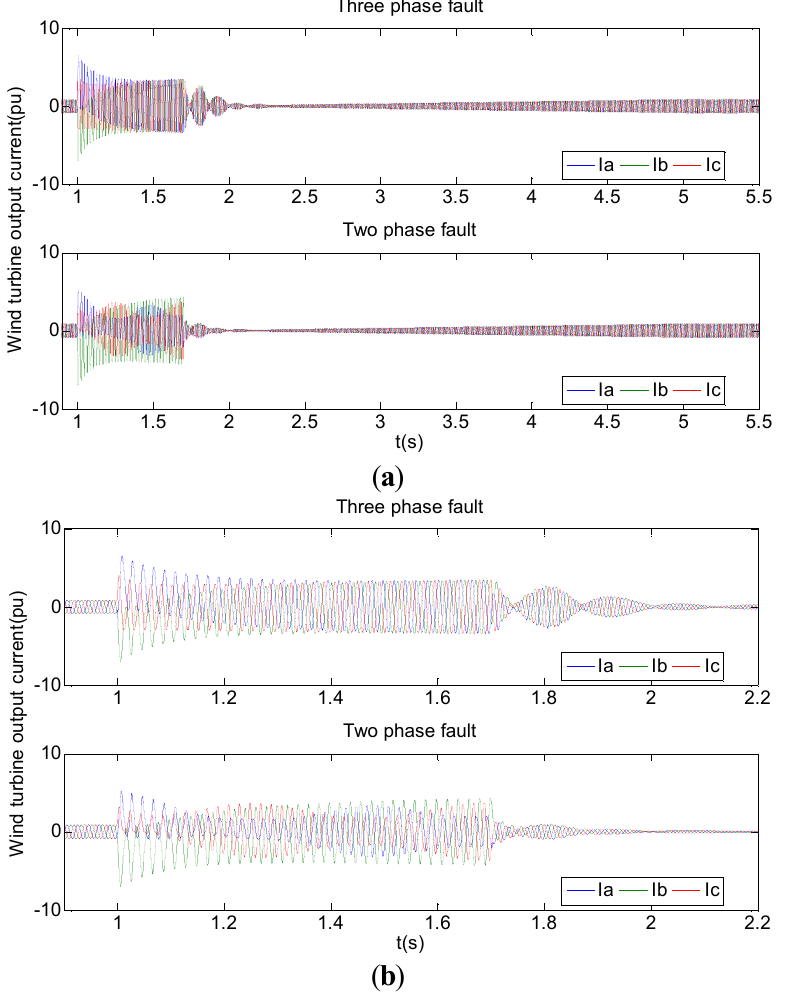
Figure 7. Wind turbine output current ( a ) 0.9–5.5 s; and ( b ) 0.9–2.2